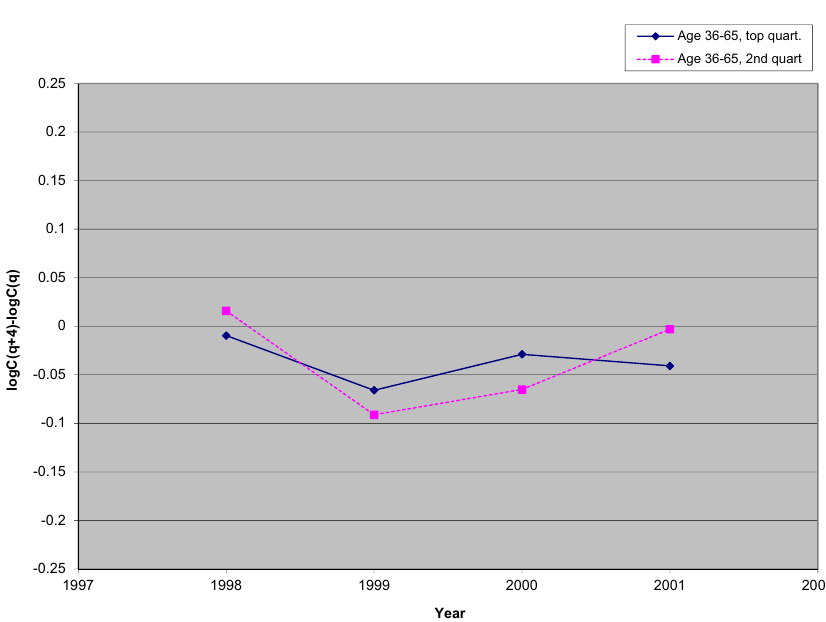
Fig. 2 Expenditure growth relative to 20–35,